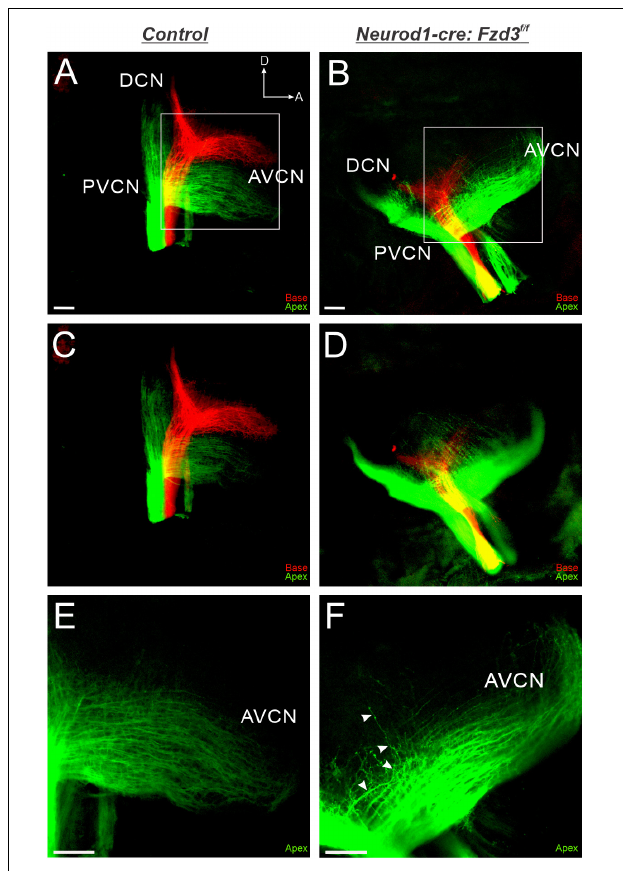
FIGURE 3 | Loss of Fzd3 in cochlear afferents results in central pathfinding defects. Lipophilic dyes were applied to the base (red) and apex (green) of control (A,C,E) and Neurod1-cre:Fzd3 f / f mutant (B,D,F) cochleae at P0 and their central projections were analyzed (A–F) . In the control, afferent neurites from the base and apex remain segregated and bifurcate, sending projections toward the DCN and AVCN (A,C) . In contrast some apical afferents in Neurod1-cre:Fzd3 f / f mutants project more dorsally, resulting in a loss of segregation between basal and apical fibers (B,D) . Stack images rendered at different depths in the CN for control (C) and Neurod1-cre:Fzd3 f / f mutant (D) central projections. Higher magnification of the AVCN (E,F) showing apical afferents projecting parallel to each other in the control (D) . Some apical afferents in the Neurod1-cre:Fzd3 f / f mutant (F) do not maintain separation from other fibers as they project toward the AVCN resulting in frequent crossover events. The white arrows show the trajectory of a single fiber as it projects in the AVCN of the Neurod1-cre:Fzd3 f / f mutant (F) . CN, cochlear nucleus; AVCN, anteroventral cochlear nucleus; DCN, dorsal cochlear nucleus; PVCN, posteroventral cochlear nucleus; A, anterior; D, dorsal. Orientation for all panels the same as (A) . Scale bars, 100 µ m. Three mutant animals and three littermate controls were